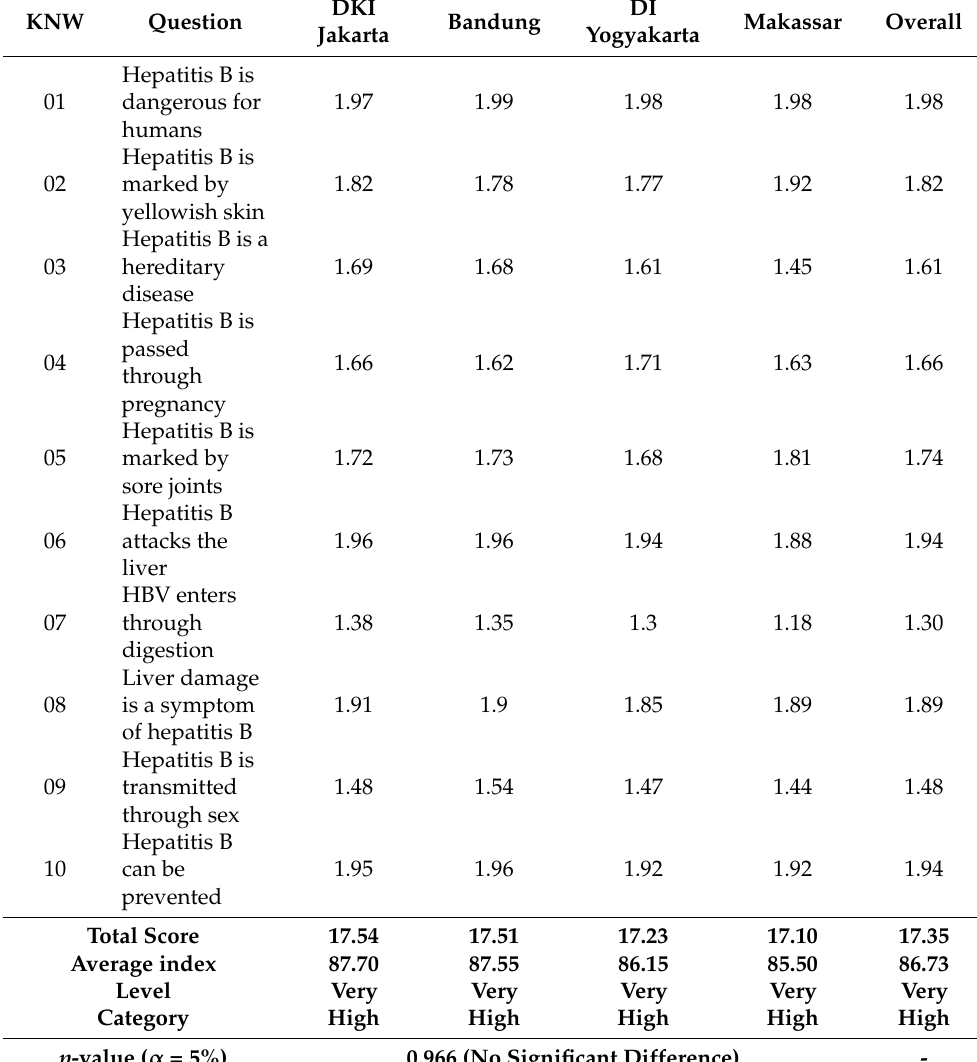
Table 3. Knowledge level on hepatitis B among the